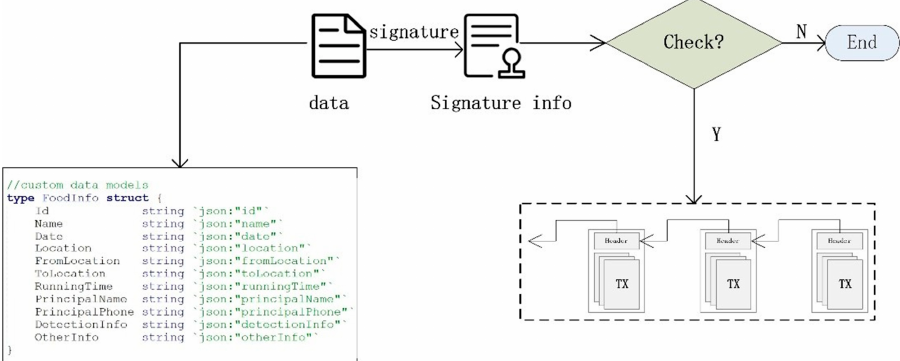
Figure 3. The process of recording data into the blockchain.